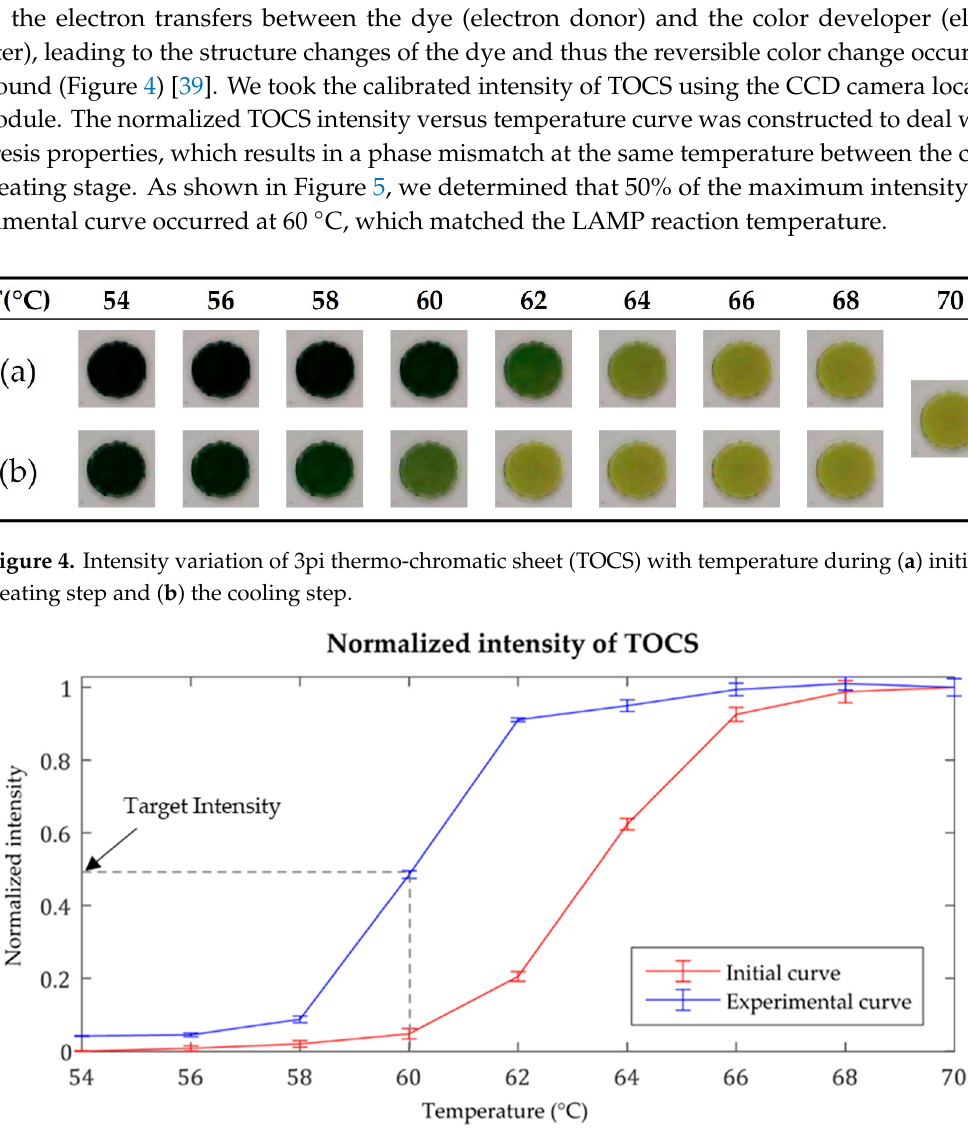
Figure 5. Normalized temperature-intensity curve of TOCS.